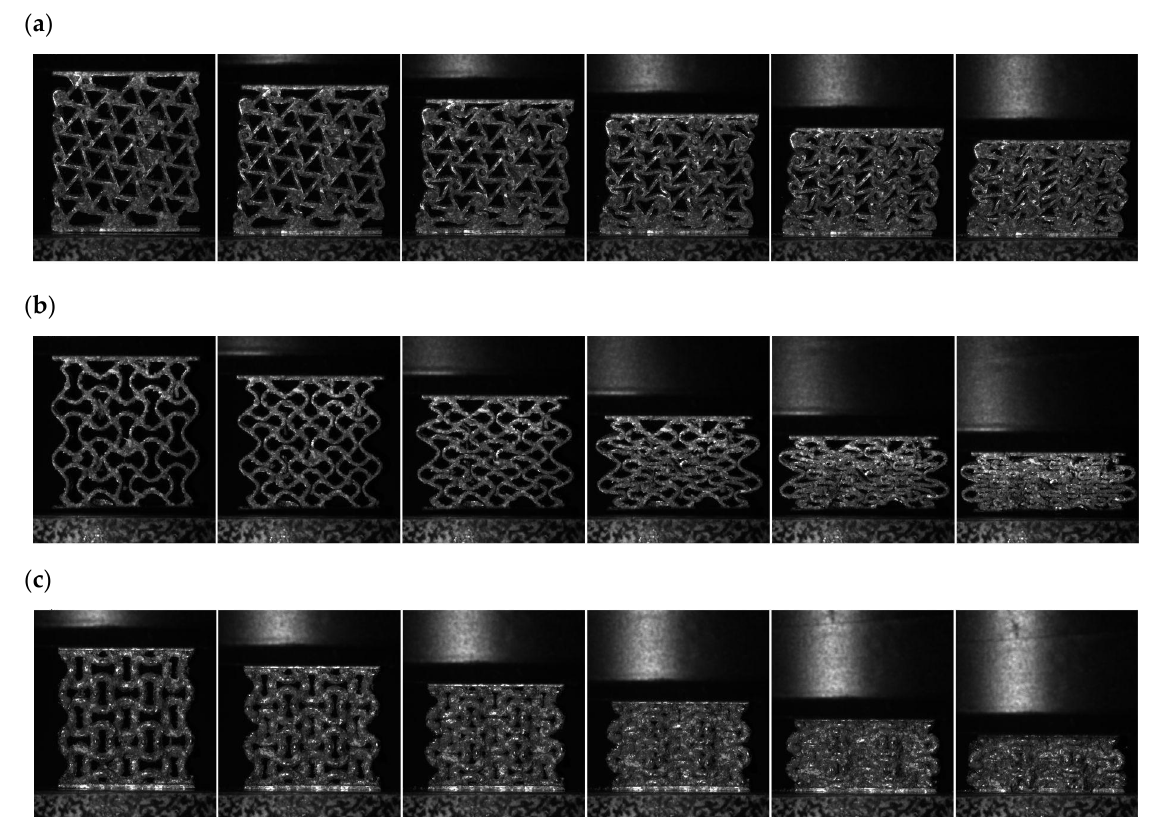
Figure 4. Average quasi-static Poisson’s ratio-strain relationships of hexa-chiral 2D, tetra-chiral 2D, and tetra-chiral 3D structure.